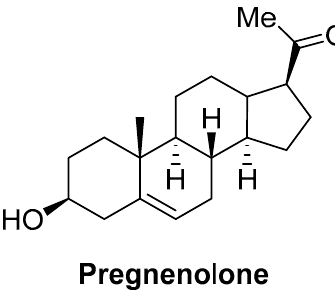
Figure 5. Structure of the CB1 endogenous allosteric modulator pregnenolone.